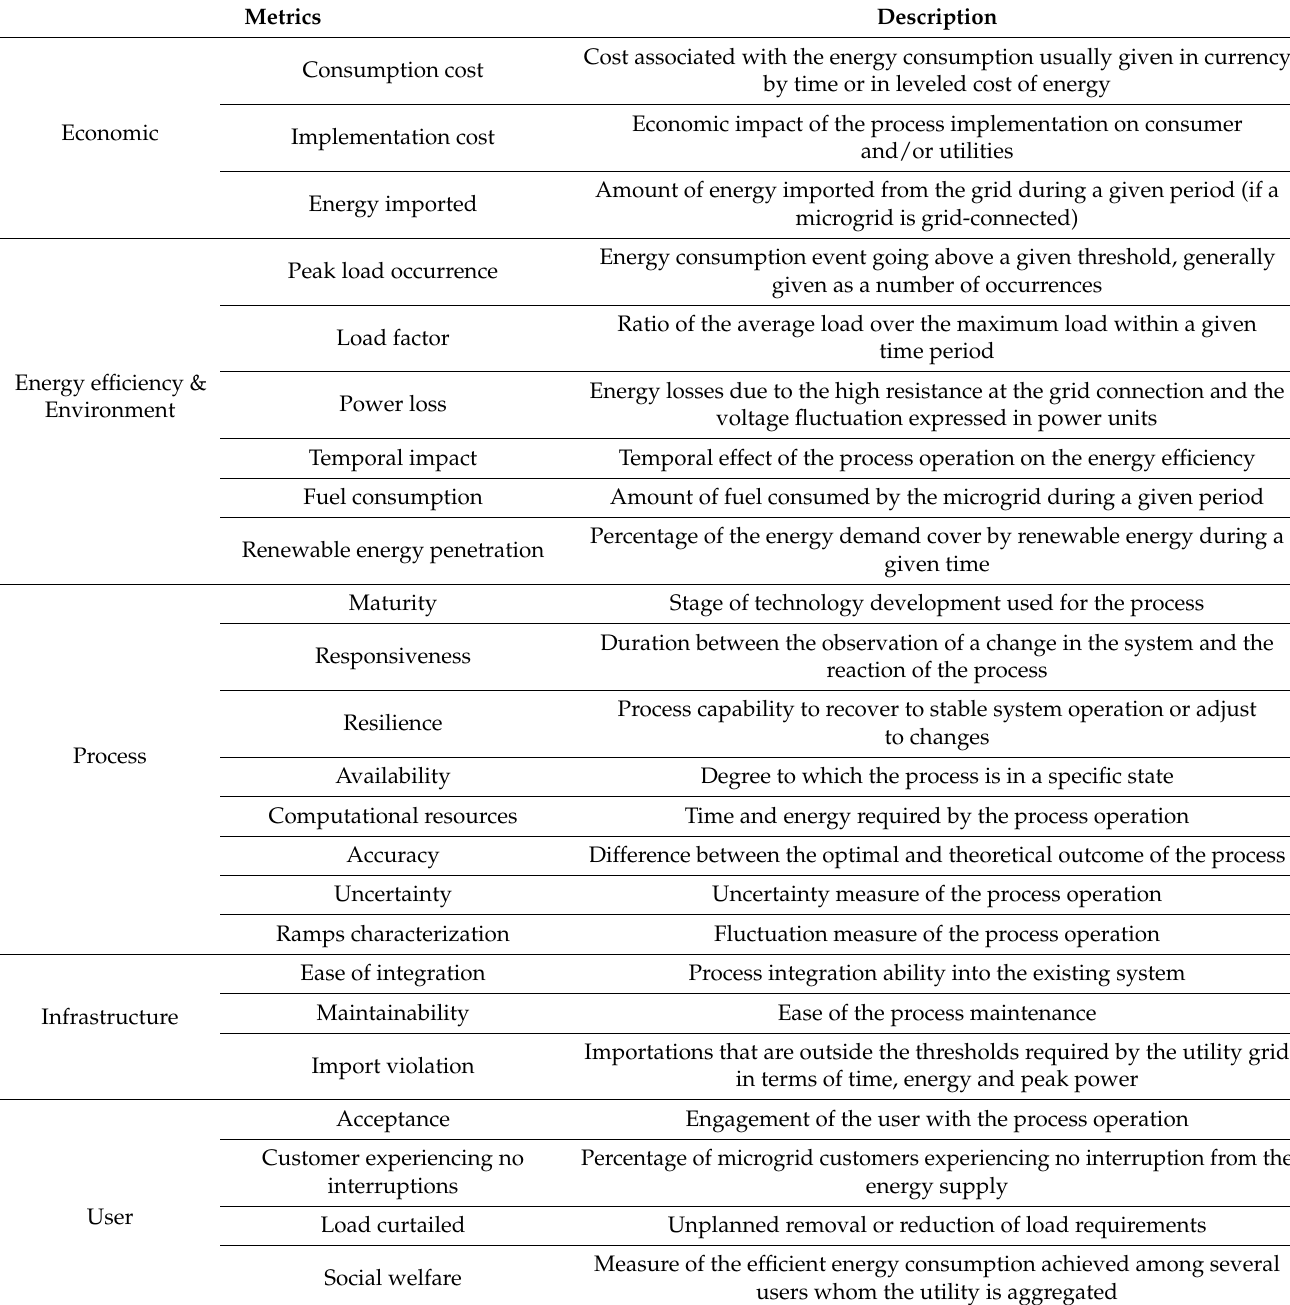
Table 9. Metrics synthesis of EMS control features